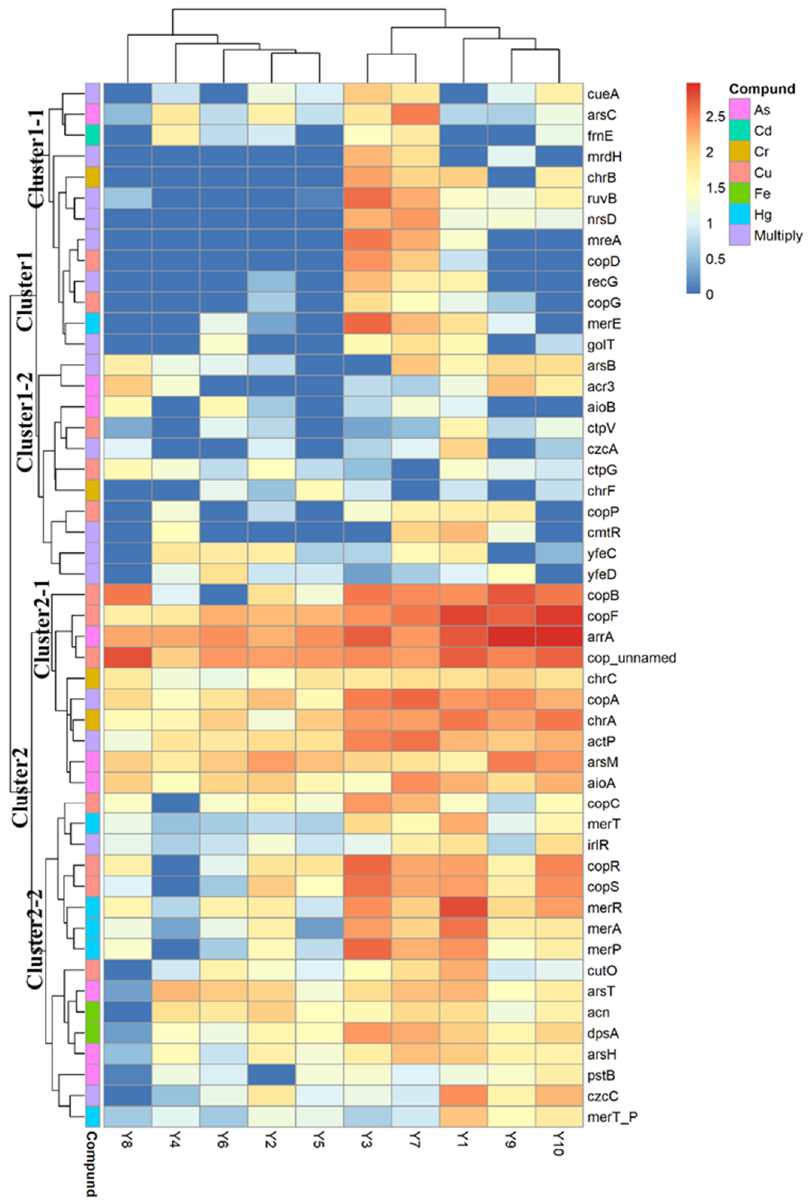
Figure 3. The content of top 50 MRGs in sediments in the Henan section of the Yellow River. The values demonstrated in the figure were calculated as follows: log10(MRG abundance × 10 4 ).